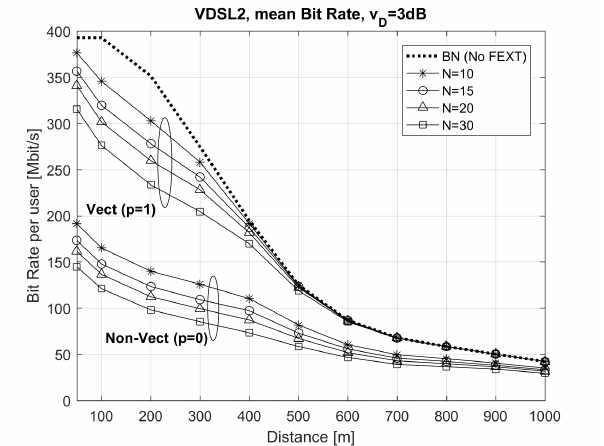
Figure 6. Bit rate per user vs. distance for VDSL2 with a variable number of users N . Non-vectoring ( p = 0), and vectoring ( p = 1) cases are displayed.